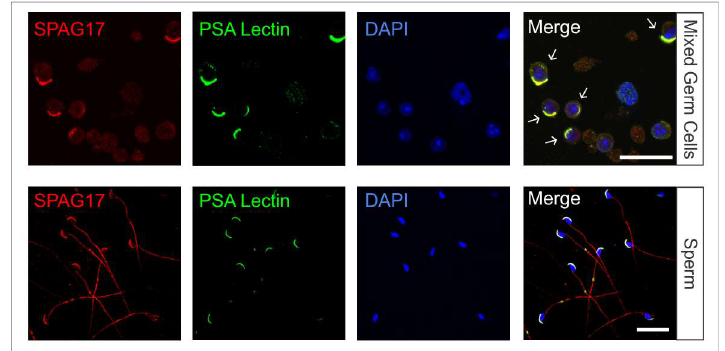
Figure 2 Figure 2. SPAG17 co-localizes with Golgi and acrosome structures. Immunofluorescence was performed on germ cells and sperm collected from wild-type mice. Pisum sativum agglutinin (PSA) lectin was used as a marker for Golgi and acrosome. The images show SPAG17 co-localization with Golgi-derived structures during spermiogenesis. The arrows indicate germ cells with co-localization of SPAG17 and PSA. Scale bars = 25 µ m.